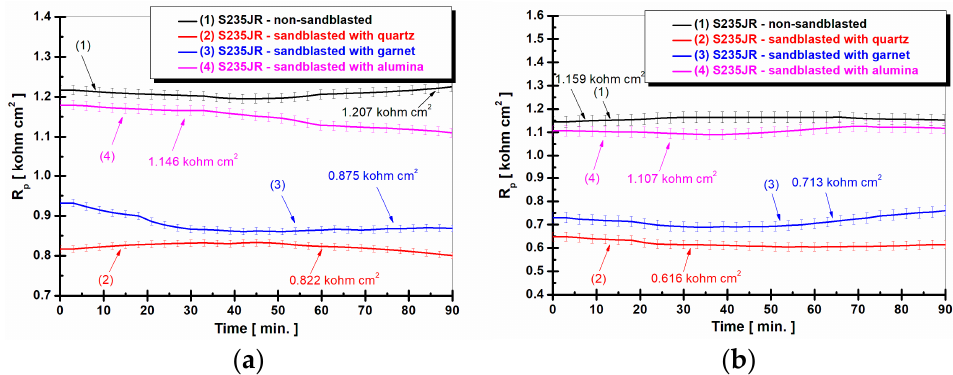
Figure 4. Evolution of polarization resistance (R p ) of S235JR steel samples immersed in 3.5% NaCl solution for (1) S235JR—non ‐ sandblasted, (2)—S235JR—sandblasted with quartz, (3)—S235JR—sandblasted with garnet, (4)—S235JR—sandblasted with alumina: ( a ) at T 1 = at immersion, ( b ) T 2 = after 336 h